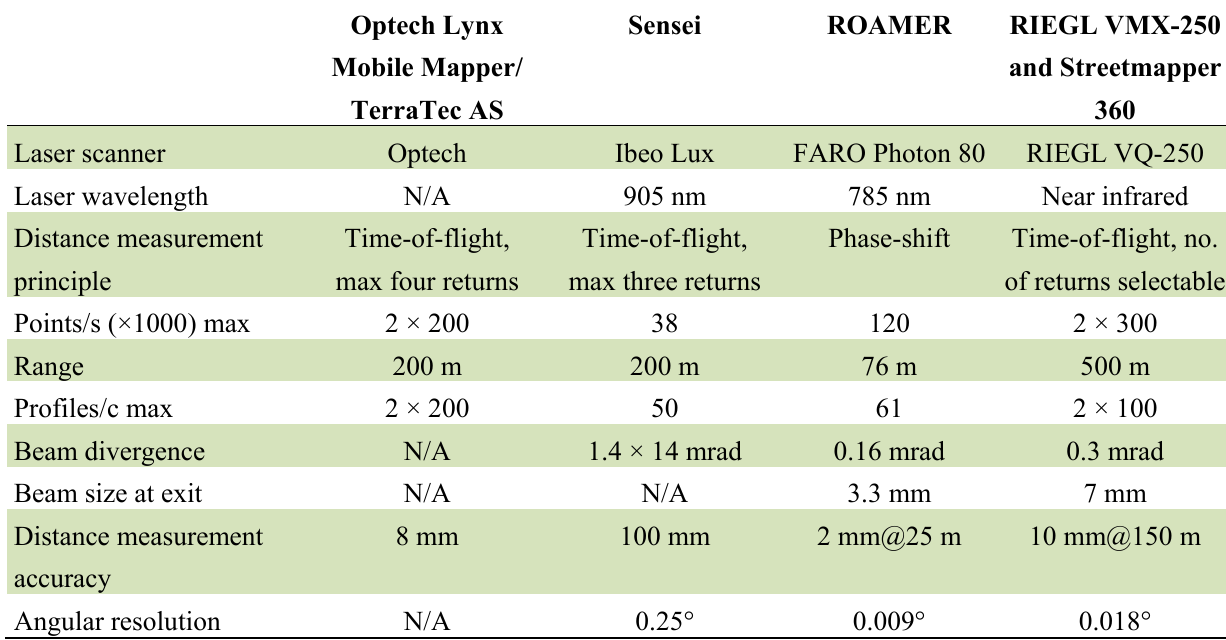
Table 2. The MLS scanner specifications